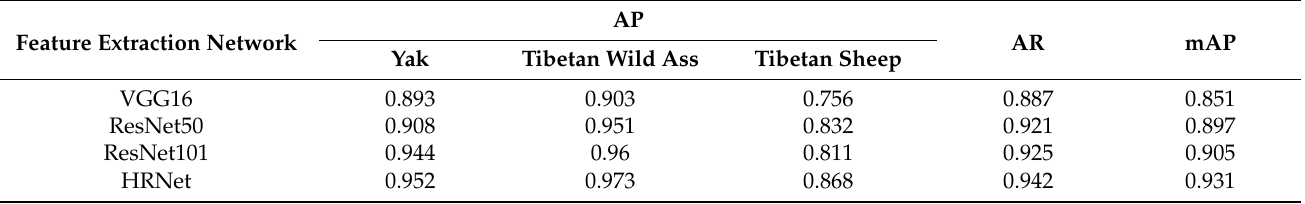
Table 1. Experimental results of the original Faster-RCNN algorithm using different feature extraction networks when IoU was